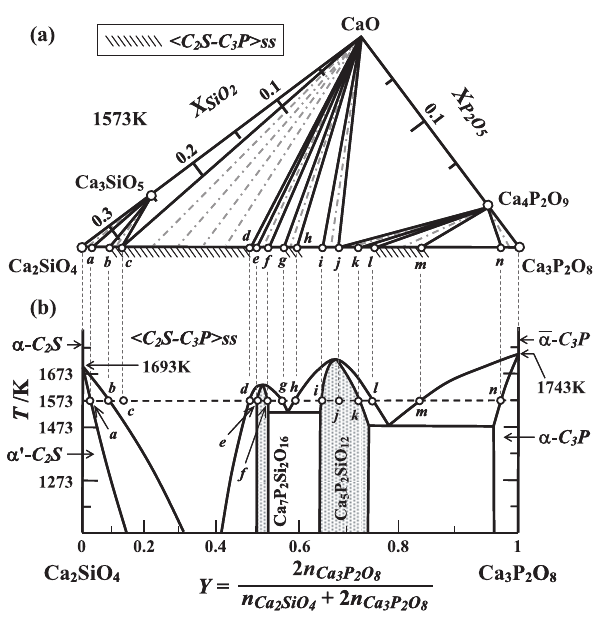
Fig. 1: (a) Iso-thermal section of the ternary system CaO-SiO 2 -P 2 O 5 near the CaO apex at 1573 K. (b) Phase diagram of the pseudo- binary system Ca